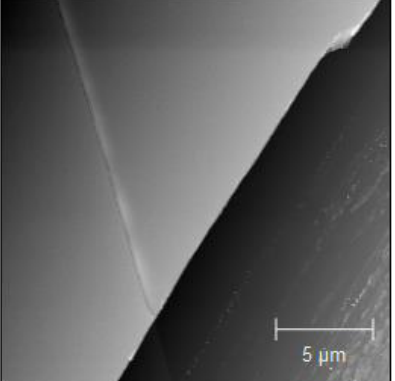
Figure 5. AFM scan of a Ni sample 138 nm thick, scratched for thickness estimation. On the left, a Ni layer is visible, and on the right—a Si wafer. A 20 × 20 µm 2 image with a resolution of 256 × 256 pixels is showing typical sample morphology.